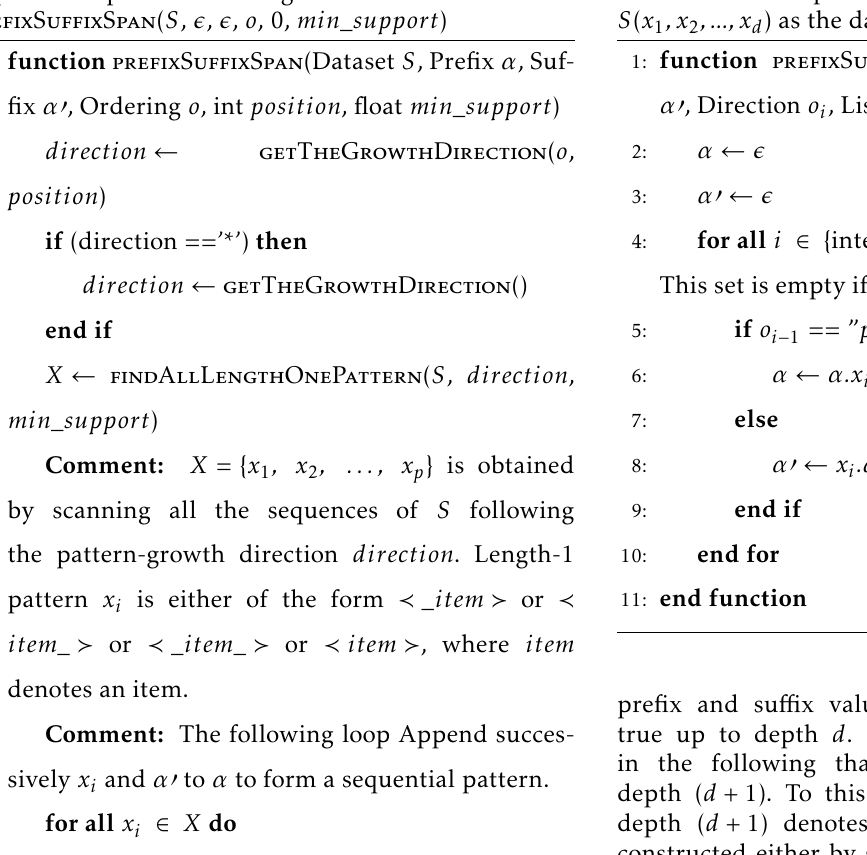
Algorithm 2 Computation of the current prefix